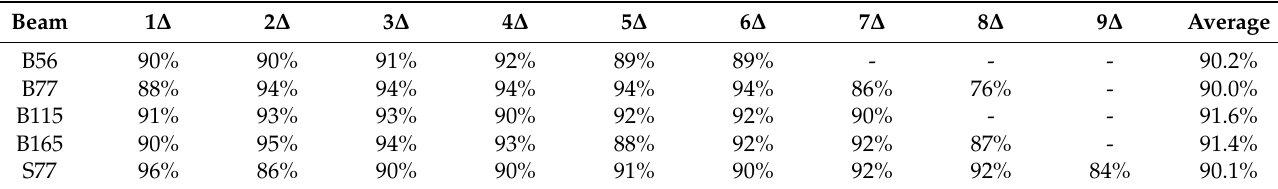
Table 5. Flexural bearing capacity degradation factors.